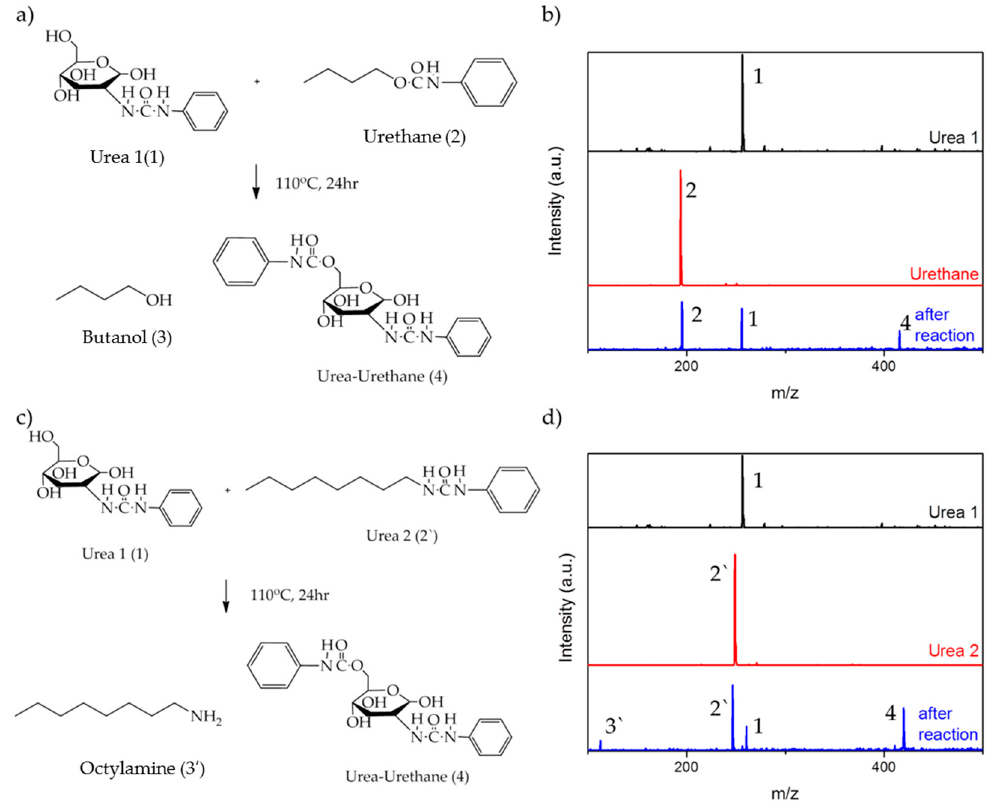
Figure 1. Exchange reactions for model compounds of chitosan, urethane units, and urea units in WPUs: ( a ) a schematic exchange reaction for the hydroxyl groups of chitosan and urethane in WPUs; ( b ) an LC/MS spectrum confirming the scheme introduced in ( a ); ( c ) a scheme of the hydroxyl group exchange reactions in chitosan and urea in WPUs; ( d ) an LC/MS spectrum confirming the scheme introduced in ( c ).